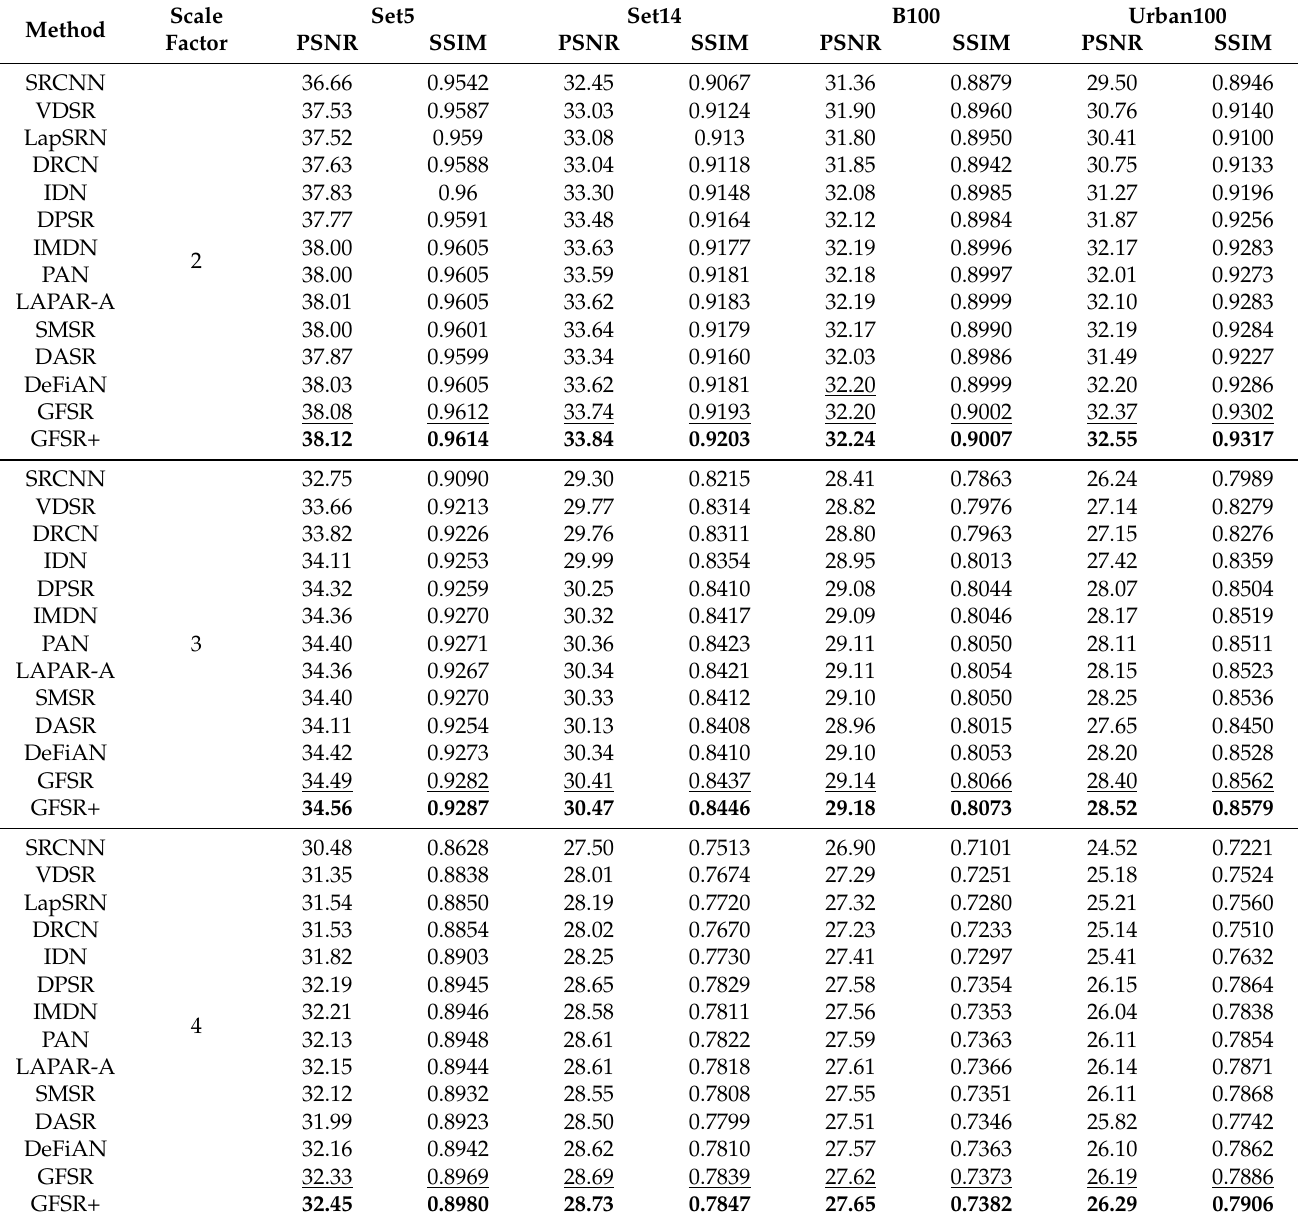
Table 6. Qualitative results of different SR models on the benchmark